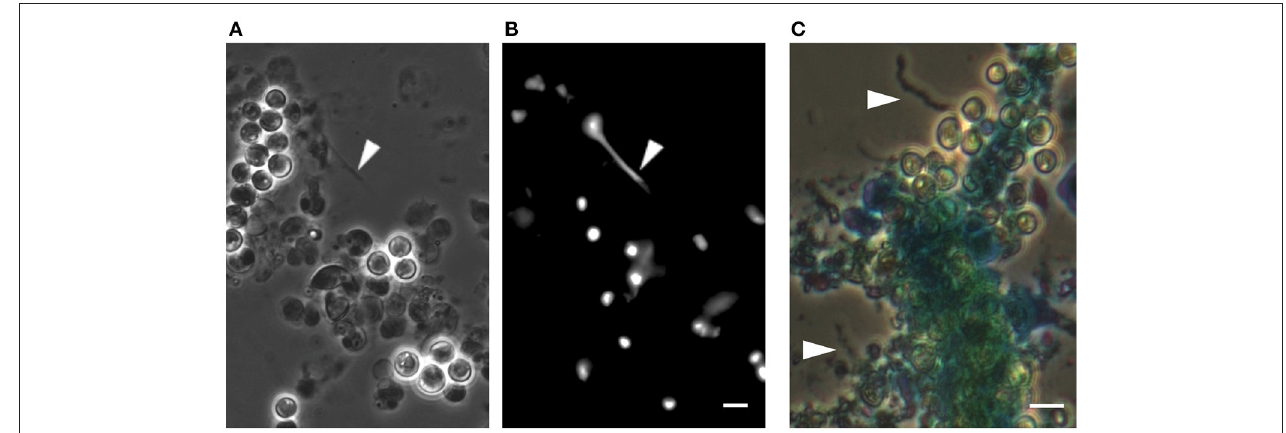
FIGURE 2 | DNA-like threads and polysaccharide fibers in algal aggregates. (A) Phase contrast microscopy of an algal aggregate reveals linear structures looking like extracellular DNA threads (see arrow head). (B) Fluorescence image of the same algal aggregate demonstrating a fluorescent signal from the threads following DNA staining with Sytox green, a dye that cannot penetrate the cell membrane and thus stains extracellular DNA as well as DNA in cells with perturebed membranes. Scale bar corresponds to 4 µ m. (C) Image of an algal aggregate stained with the polysaccaride-binding stain alcian blue. Individual fiber-like structures are seen (indicated by arrow heads). The central mass of algal cells appears to be encased in a matrix that absorbed the stain, suggesting an exopolysaccharide composition similar to TEP. Scale bar corresponds to 4 µ m. See Data Sheet 1 for Materials and Methods.